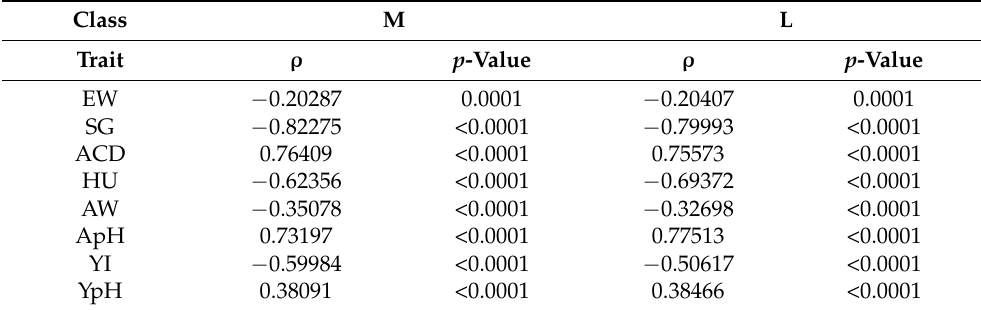
Table 1. Spearman’s correlation coefficients between particular quality traits of eggs and days of